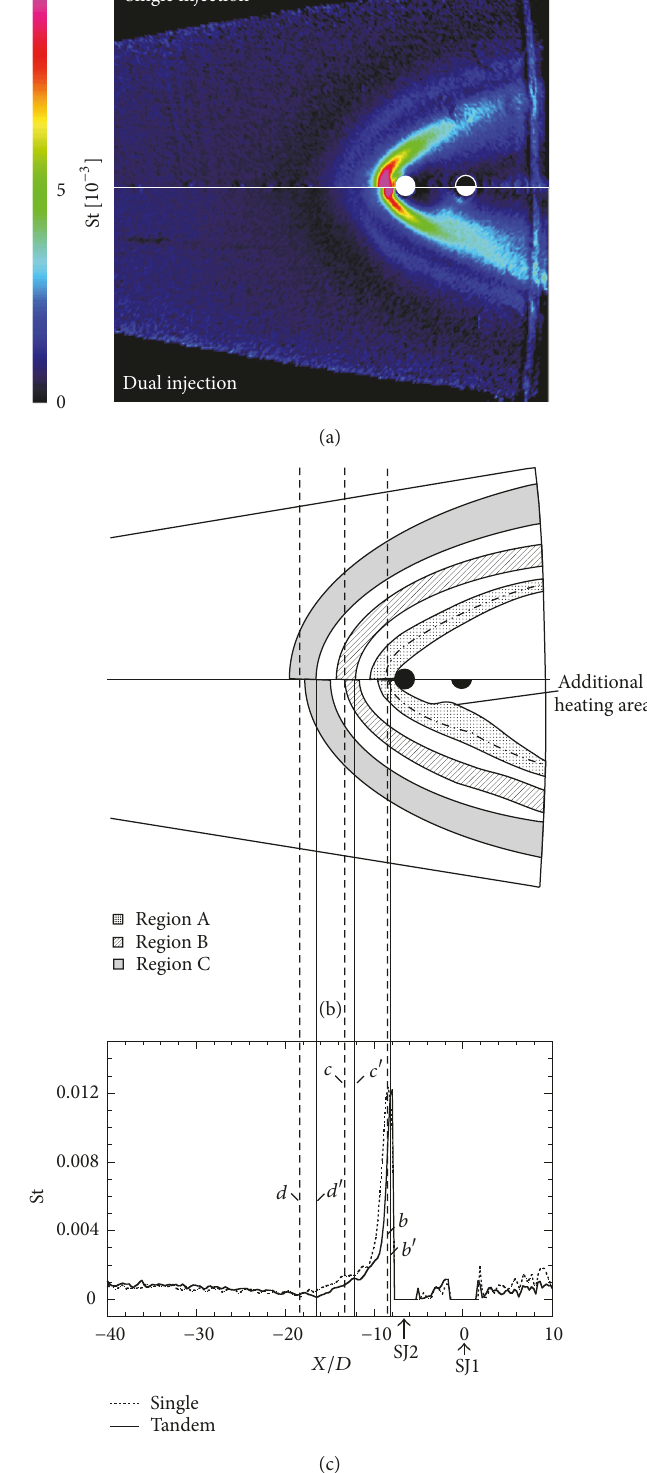
Figure 13: St distribution in the tandem configuration for 𝑆 𝑥 /𝐷 = 6.72 . (a) Surface distribution of Stanton number measured by TSP, (b) schematic of the heating patterns, and (c) one-dimensional profile of on the 𝑥 -axis, with single and tandem dual injection at 𝑆 𝑥 = 6.72𝐷 . Point b , locus with peak; point c , peak of separation vortex; and point d , separation point. Prime marks indicate the points with dual injections. The upper half of (a) and (b) displays a single injection case and the lower half a dual injection